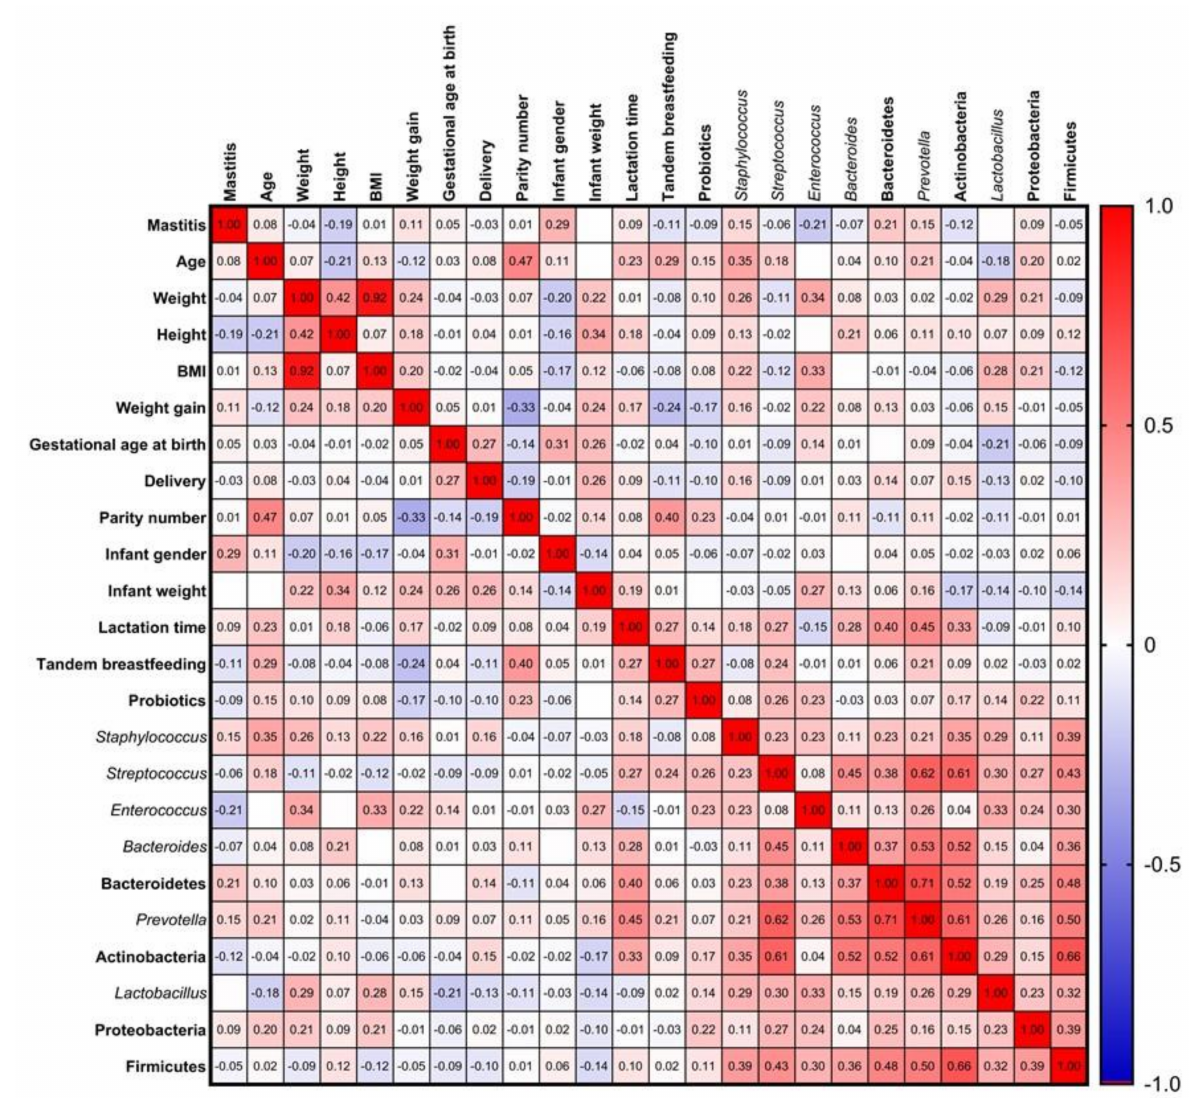
Figure 7. Graphical Spearman correlation matrix showing pairwise correlations between diverse maternal factors and microbiota profiles in healthy Spanish mothers; colours are added for better visualization of correlation r